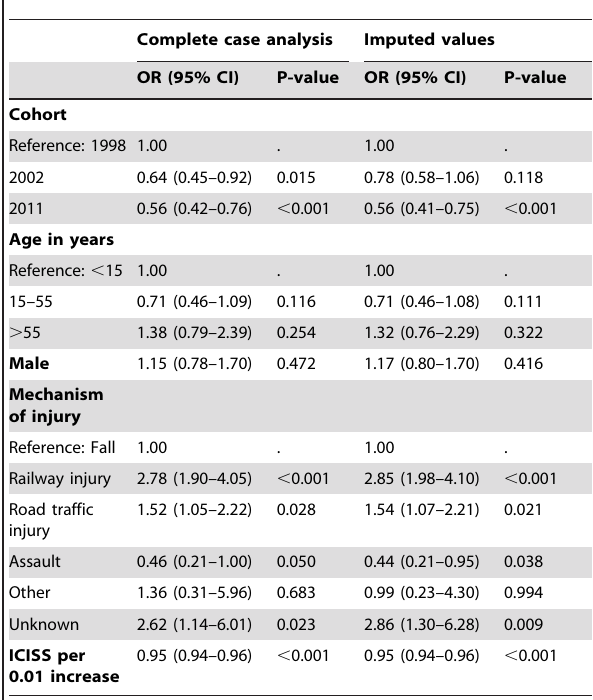
Table 4. Multivariate logistic regression model